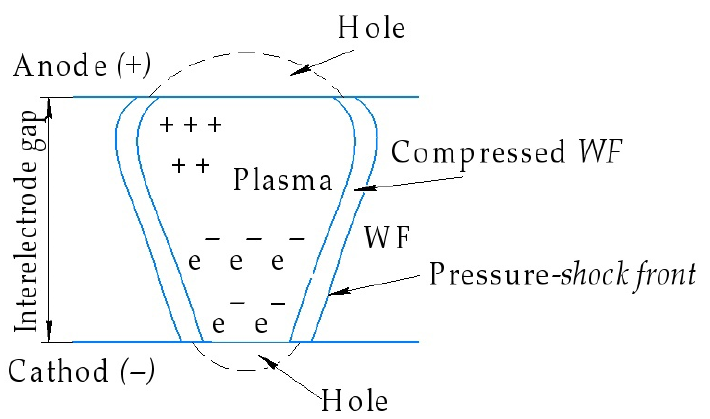
Figure 1. Plasma channel.